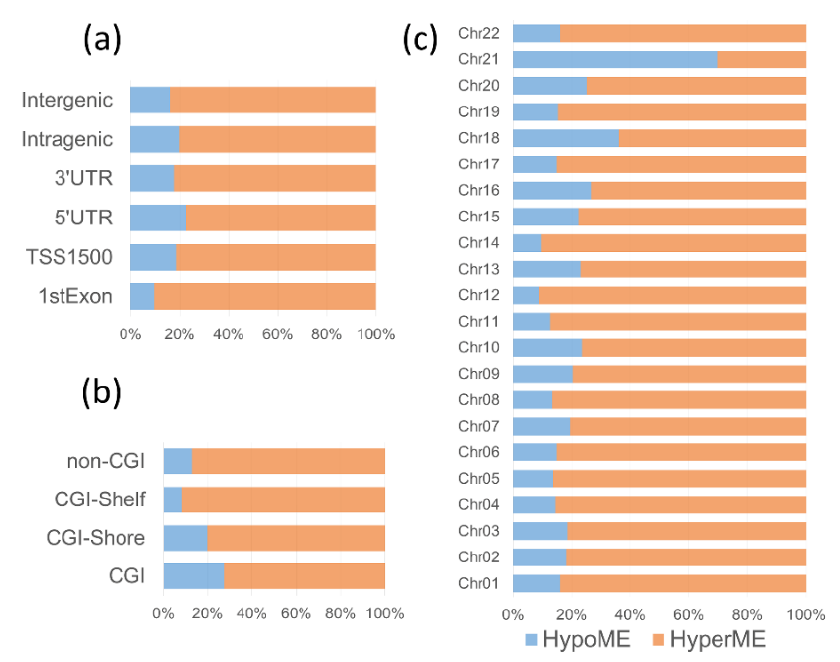
Figure 3. The percentage of the hypermethylated (HyperME) and hypomethylated (HypoME) DS-associated DMPs by gene regions ( a ), CpG islands, CGIs ( b ), and autosomes ( c ).